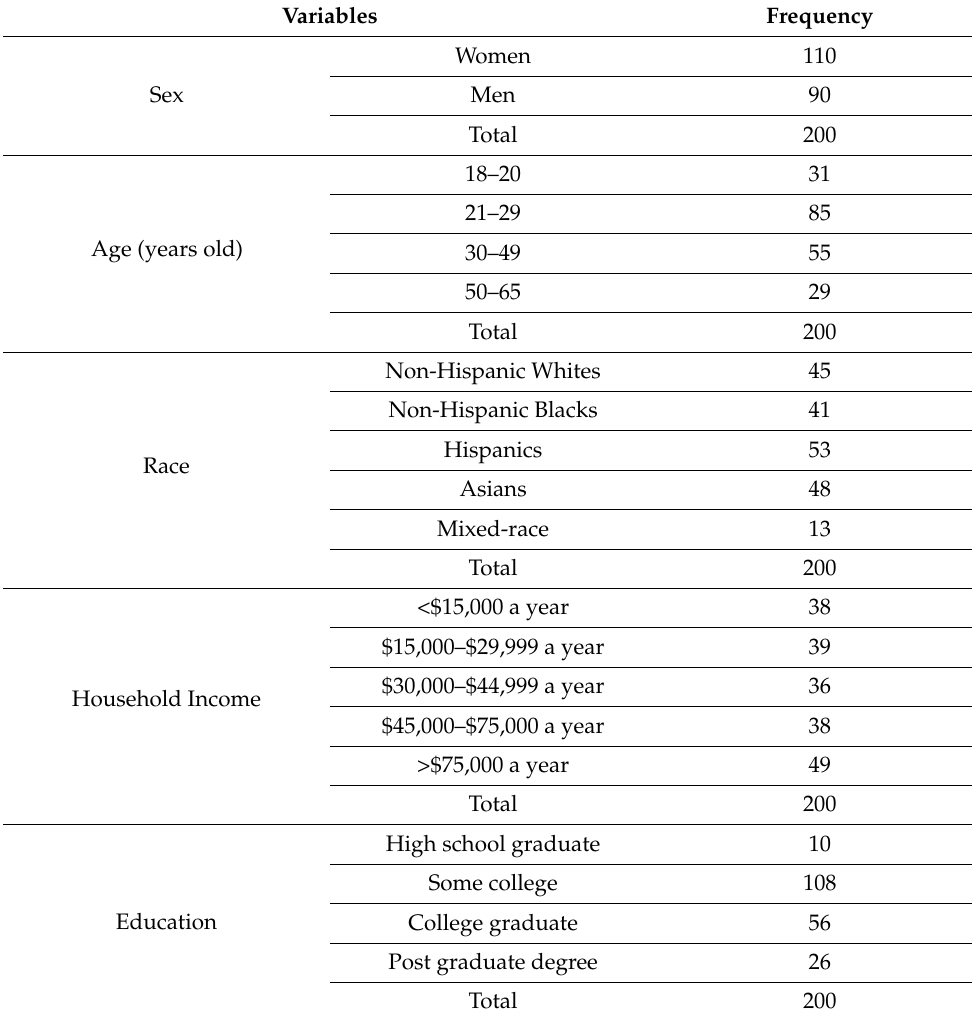
Table 2. Demographic characteristics of 200 consumers participating in this miracle fruit product consumer